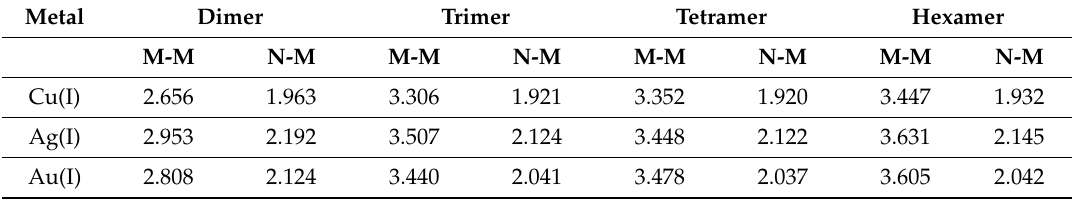
Figure 14. Schematic representation of the ududud structure.